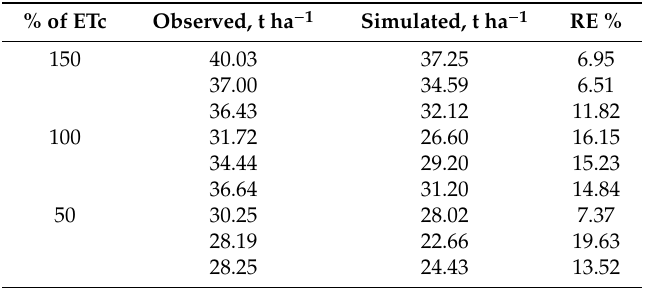
Table 8. Observed versus simulated total potato yield.